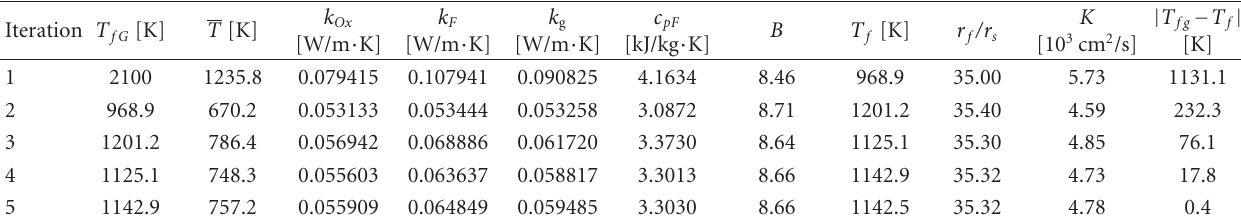
Table 1: Simple quasi-steady model n -heptane results.